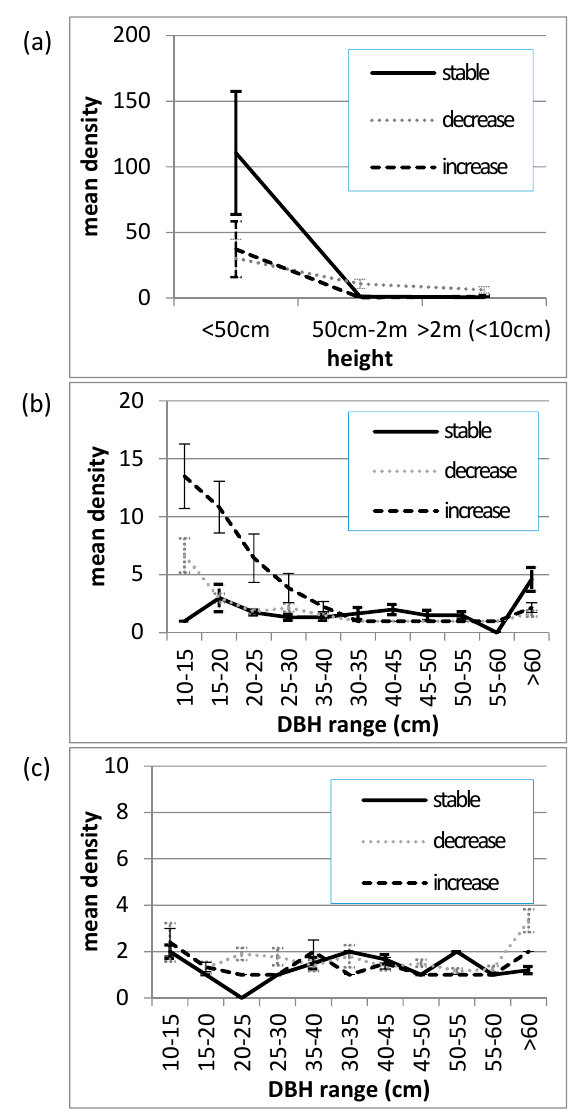
Figure 4. Mean size-class distributions of Allosyncarpia ternata ( a ) juveniles (<10 cm DBH); ( b ) living stems; ( c ) dead stems, at 0.1 ha transects ( n = 29) describing stable ( n = 8), decreasing ( n = 14), and increasing ( n = 7) canopy cover conditions, over the period 1982/87–2010. (Error bars represent the standard error of the mean).